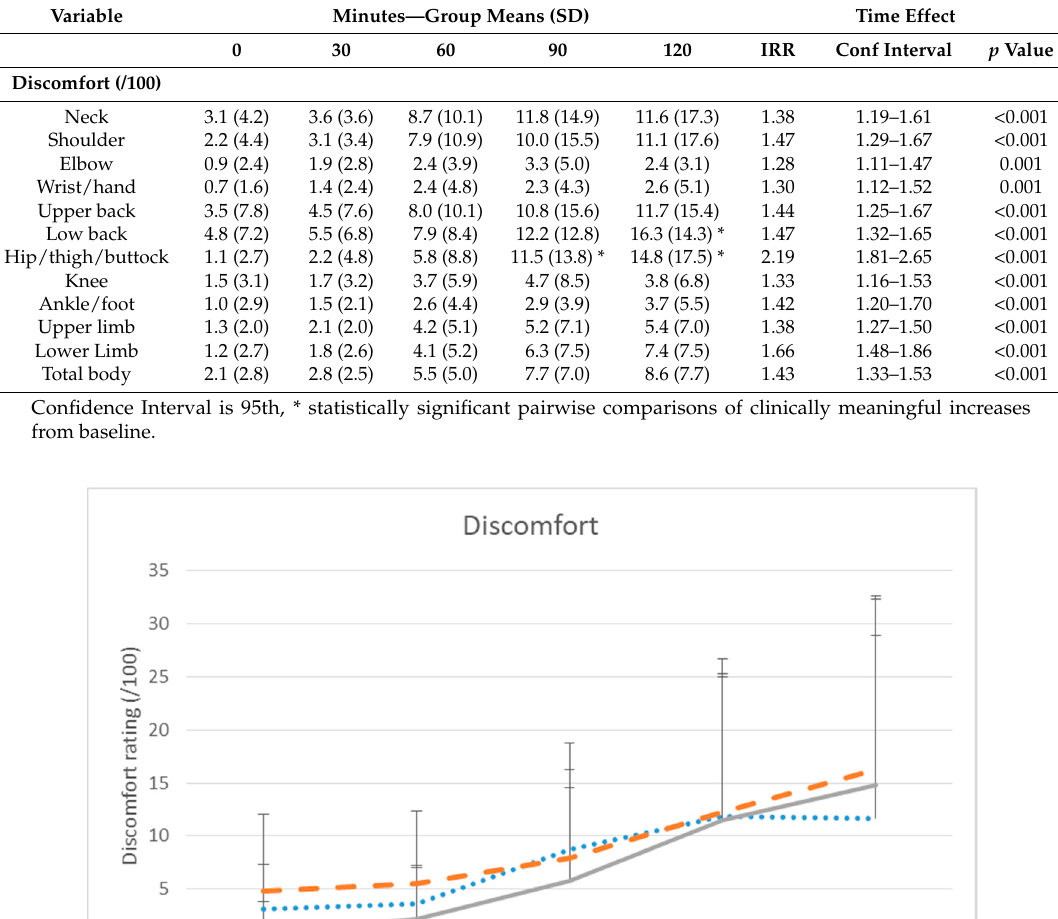
Table 1. Discomfort [mean (standard deviation)] over 2 h of prolonged sitting with incident rate ratio (IRR) for effect of time.